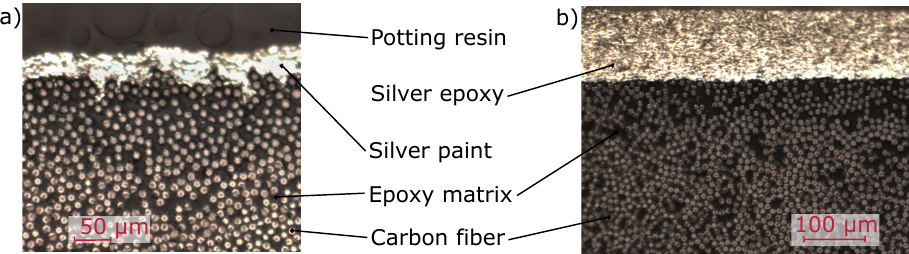
Figure 9. Comparison of a cross section contacted with ( a ) silver paint and ( b ) silver